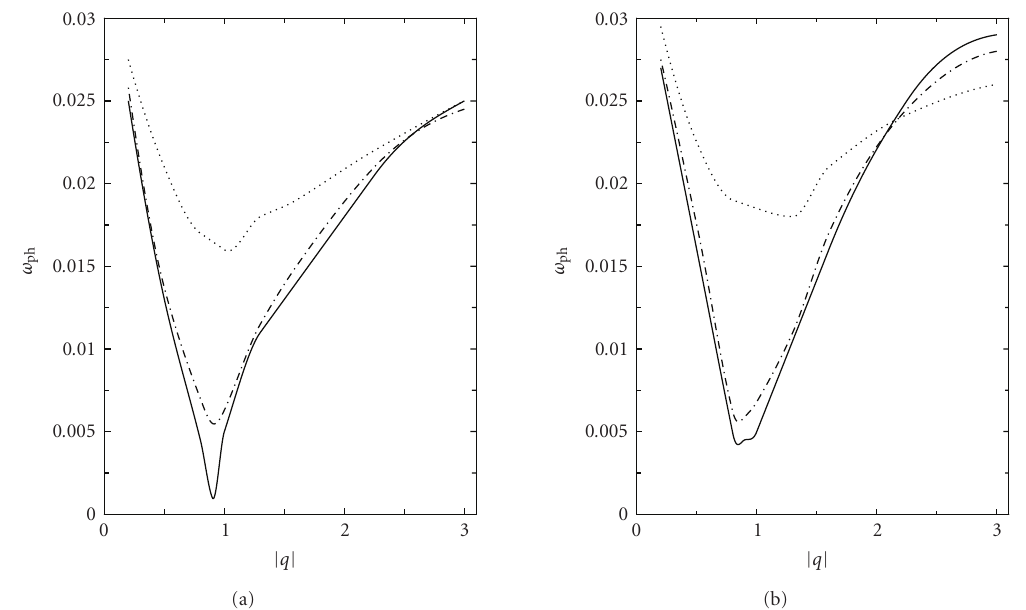
Figure 13: Phonon dispersion curves (a) in the instability (0.28,0.86) direction and (b) in the (1,1) direction, for t = 0 . 5eV, t (cid:14) = − (1 / 6) t , √ 2 eV, ω 0 = 0 . 04 eV, and V C = 0 . 55 eV. The solid curves correspond to the critical doping δ c = 0 . 195, the dot-dashed and the g = 0 . 240 / dotted curves correspond to δ = 0 . 21 and δ = 0 . 3,